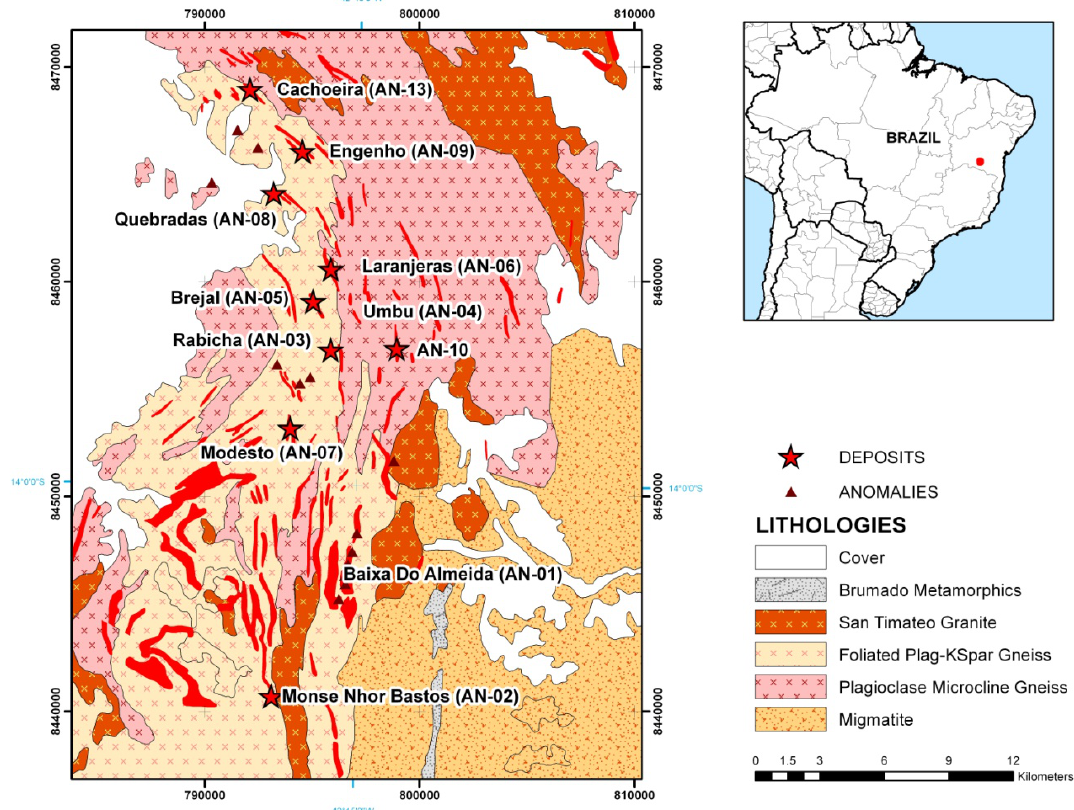
Figure 3. Relationship of uranium deposits to regional albititisation, Lagoa Real district of Brazil. Modified after [3]. Distribution of albitites shown in